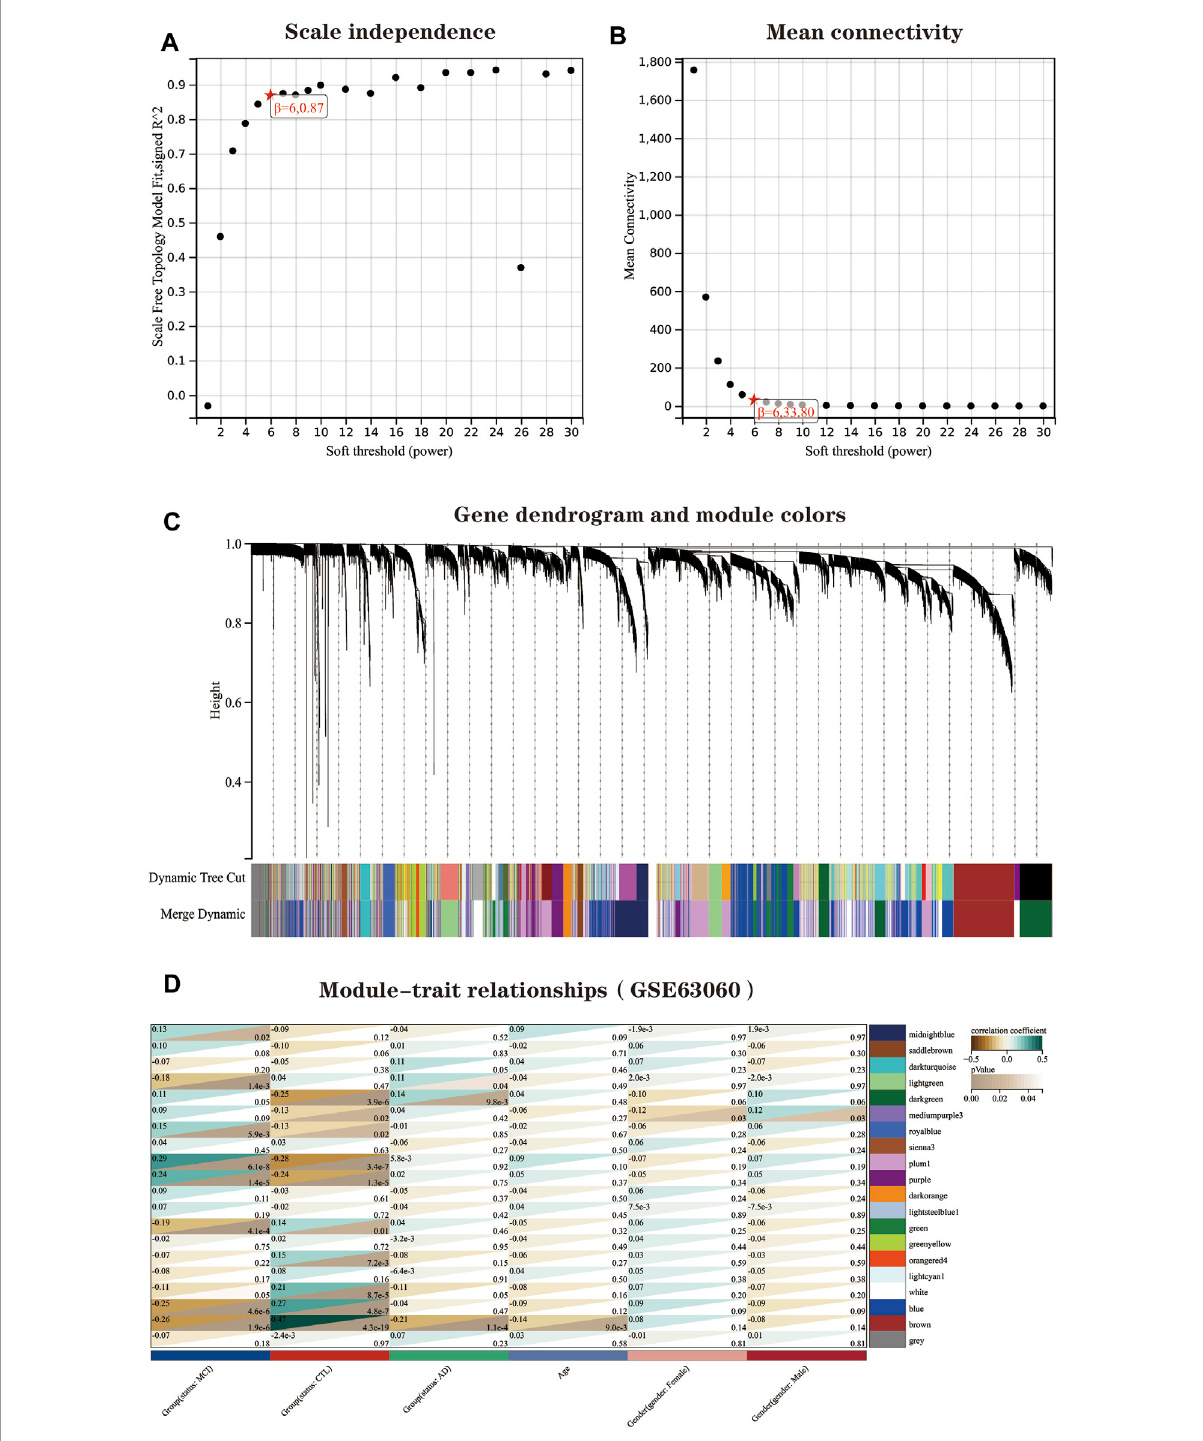
FIGURE 4 WGCNA ofAD dataset GSE63060. (A) Scale-freeindexfor analyzing thepowerofvarioussoftthresholds. The horizontal coordinate represents the power of soft thresholds, and the best soft threshold is marked with an asterisk. (B) Average connectivity of various soft thresholds. (C) Identi fi cation of co-expressed gene modules. A dendrogram of all differentially expressed genes was clustered based on a measure of gene similarity. Cut lines of modules were identi fi ed, and a different color indicated each module. (D) Heat map of the correlation between modules and clinical phenotypes. Each row represents a module; each column represents a clinical trait. Each cell indicates the correlation between the